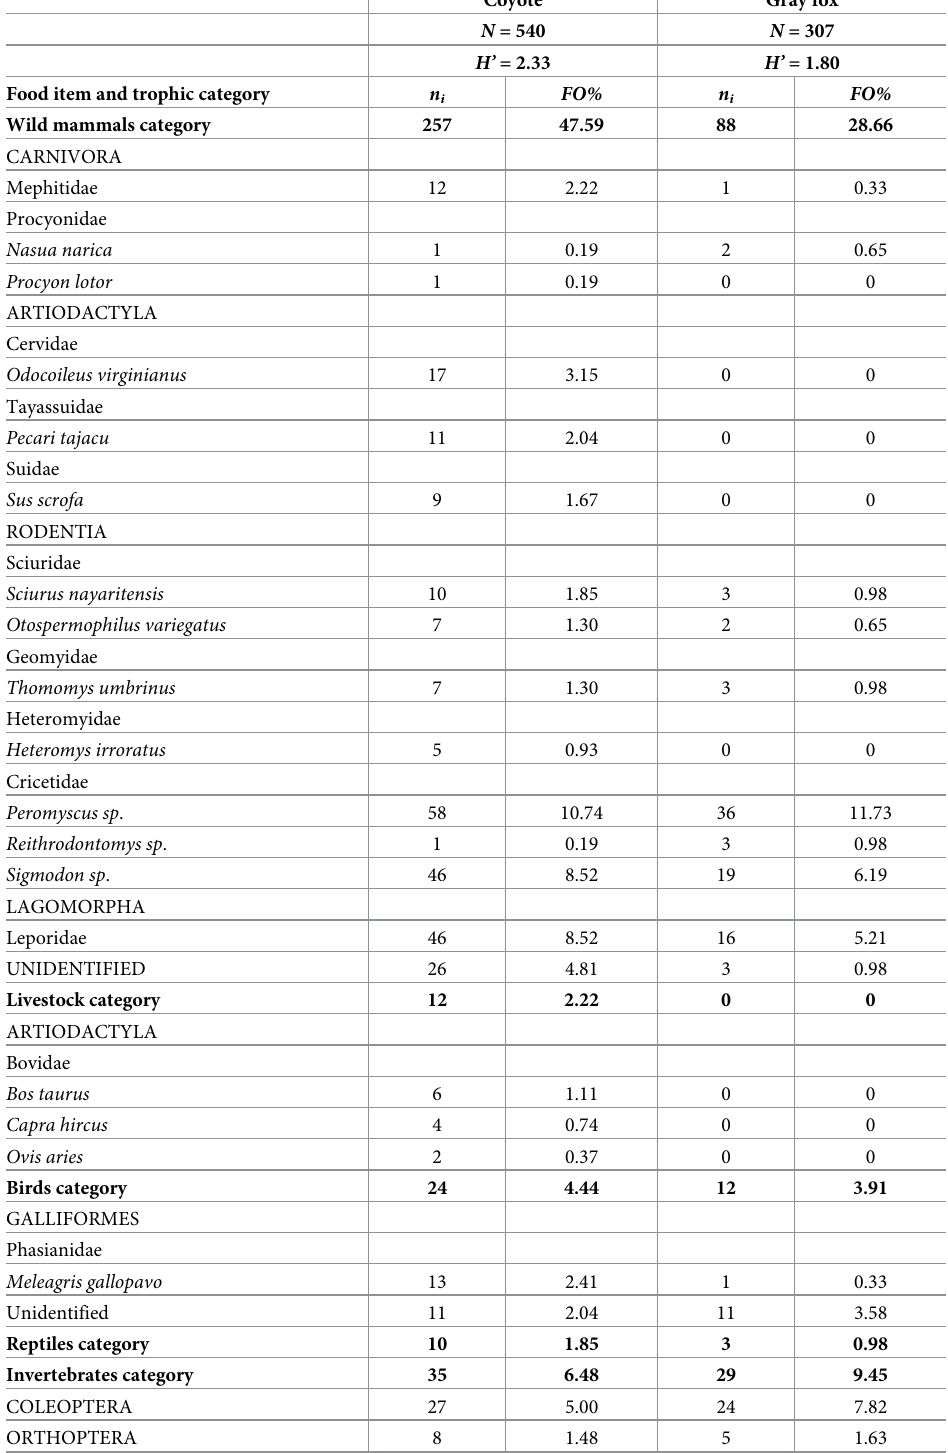
Table 1. Total number of samples ( N ) and trophic diversity ( H’ ) of the coyote and gray fox, as well as overall num- ber of occurrences (